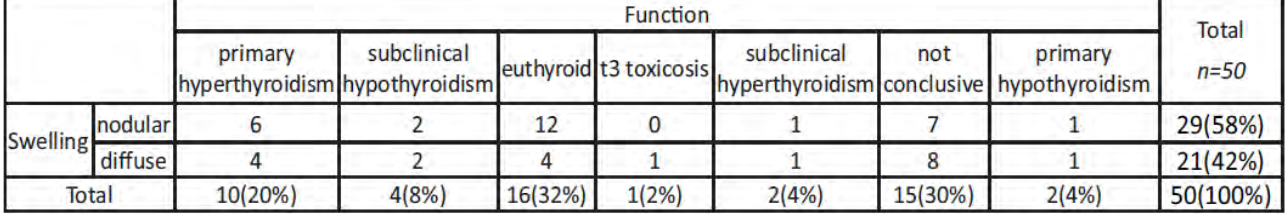
Table 3: Cross tabulation between swelling and TFT